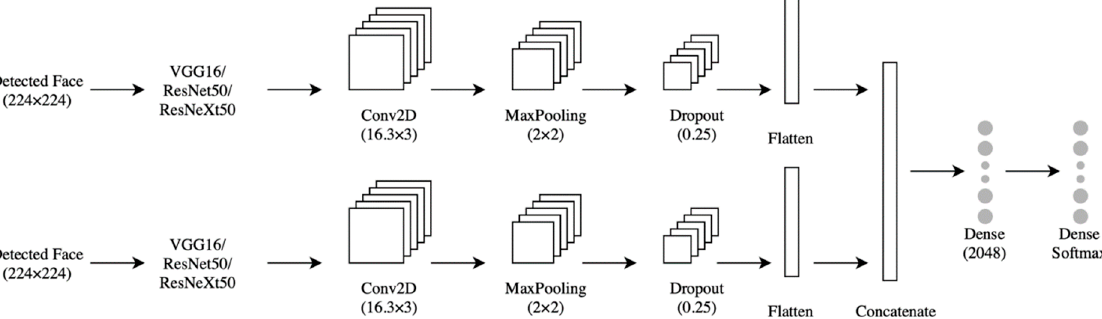
Figure 5. The concurrent shallow CNN model using (VGG16/ResNet50/ResNeXt50) with frozen layers.